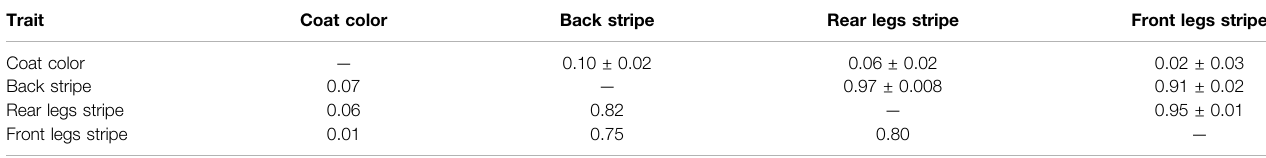
TABLE 6 | Estimated genetic correlations ± standard errors (above diagonal) and phenotypic correlations (bellow diagonal) for scored autochthonous traits from Group 4. Trait Coat color Coat color